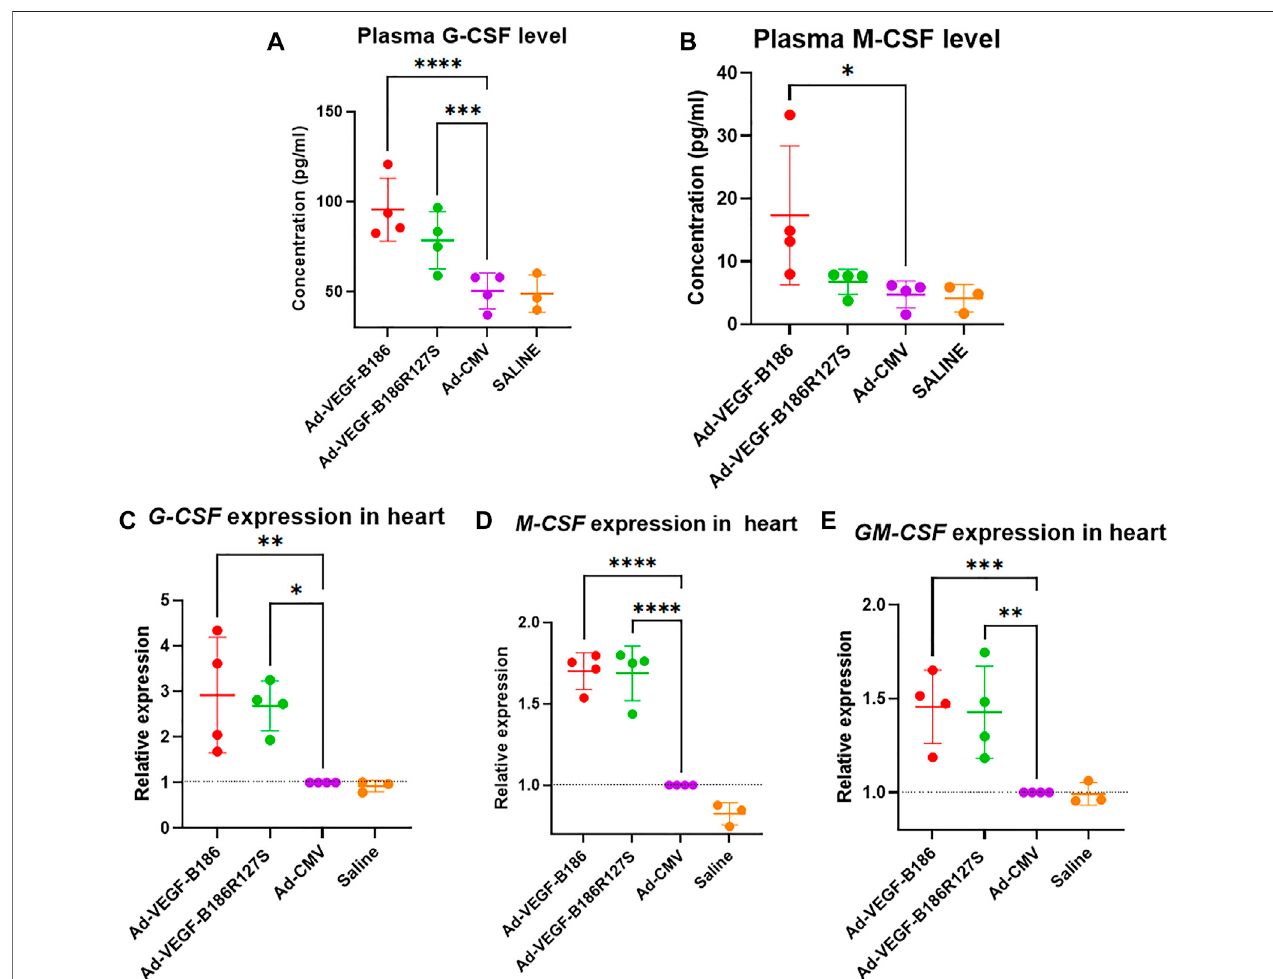
FIGURE 4 | VEGF-B isoforms upregulate hematopoietic growth-inducing cytokine expression. (A and B) Comparison of plasma G-CSF and M-CSF levels 6 days after gene transfer. (C – E) Comparison of G-CSF, M-CSF and GM-CSF expression in heart 6 days following gene transfer. Each dot indicates one mouse; n = 4 in Ad- VEGF-B186, n = 4 in Ad-VEGF-B186R127S, n = 4 in Ad-CMV, and n = 3 in saline groups. Horizontal bars indicate mean ± SD and p values vs. each group by one-way ANOVA, followed by Dunnett ’ s multiple comparison test.